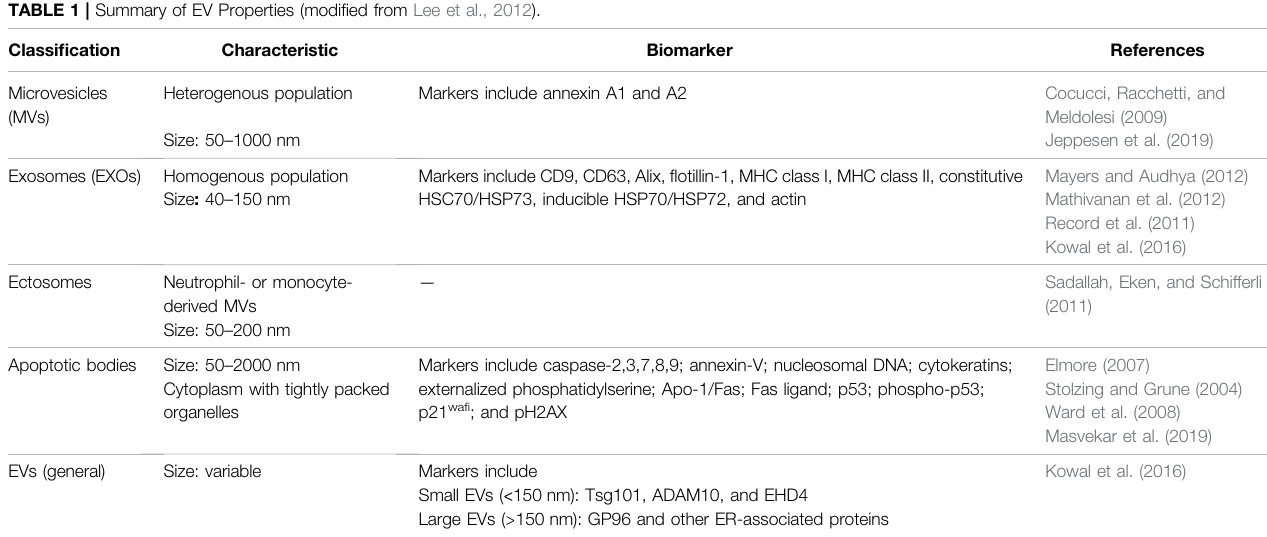
TABLE 1 | Summary of EV Properties (modi fi ed from Lee et al.,